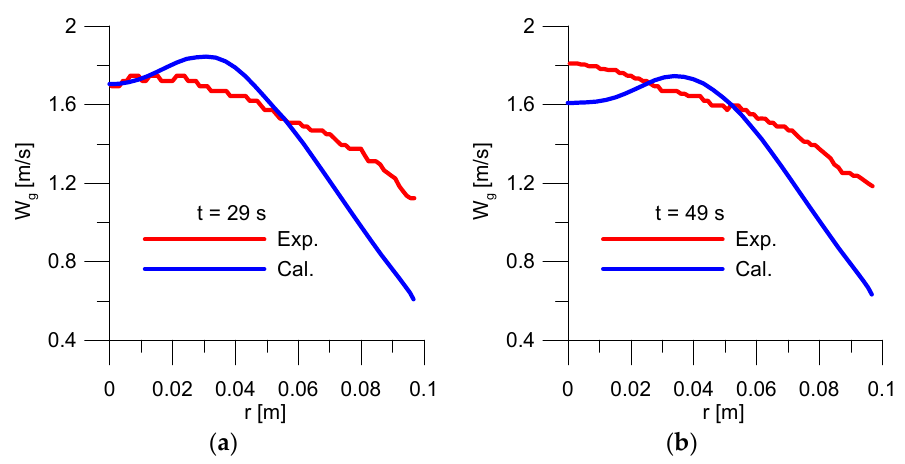
Figure 17. Evolution of radial gas velocity profiles at the WMS plane (Case 2): ( a ) t = 29 s; ( b ) t = 49 s.